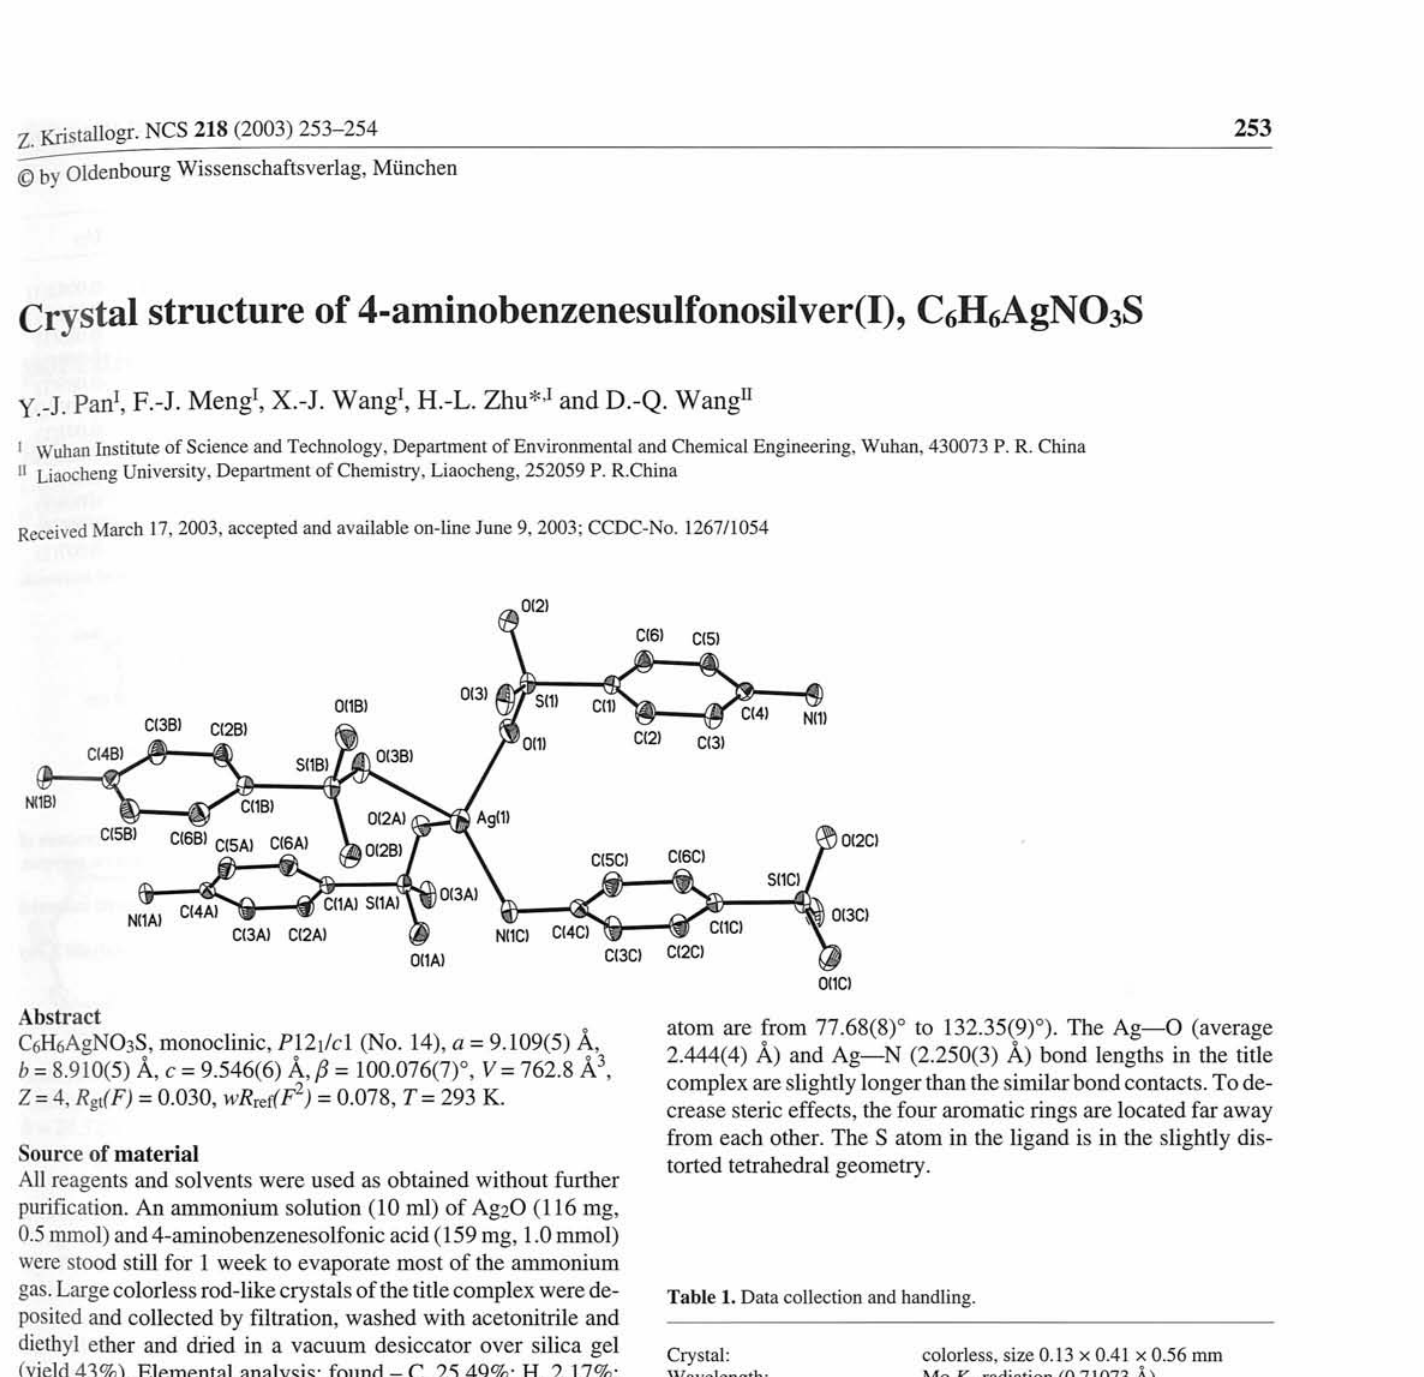
Table 1. Data collection and handling.